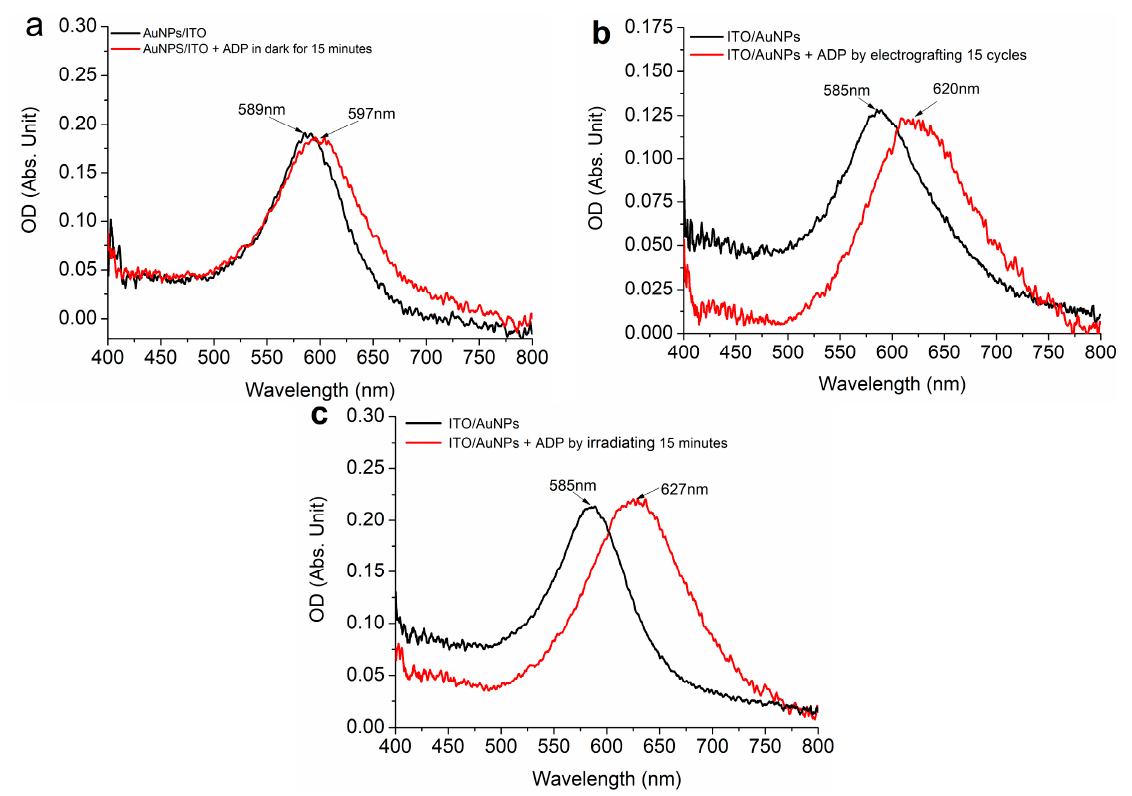
Figure 3. Extinction spectra of deposited AuNPs/ITO before and after ( a ) 15 min of spontaneous grafting in the dark; ( b ) 15 cycles of grafting by electrochemical grafting; ( c ) 15 min of irradiation by visible light.